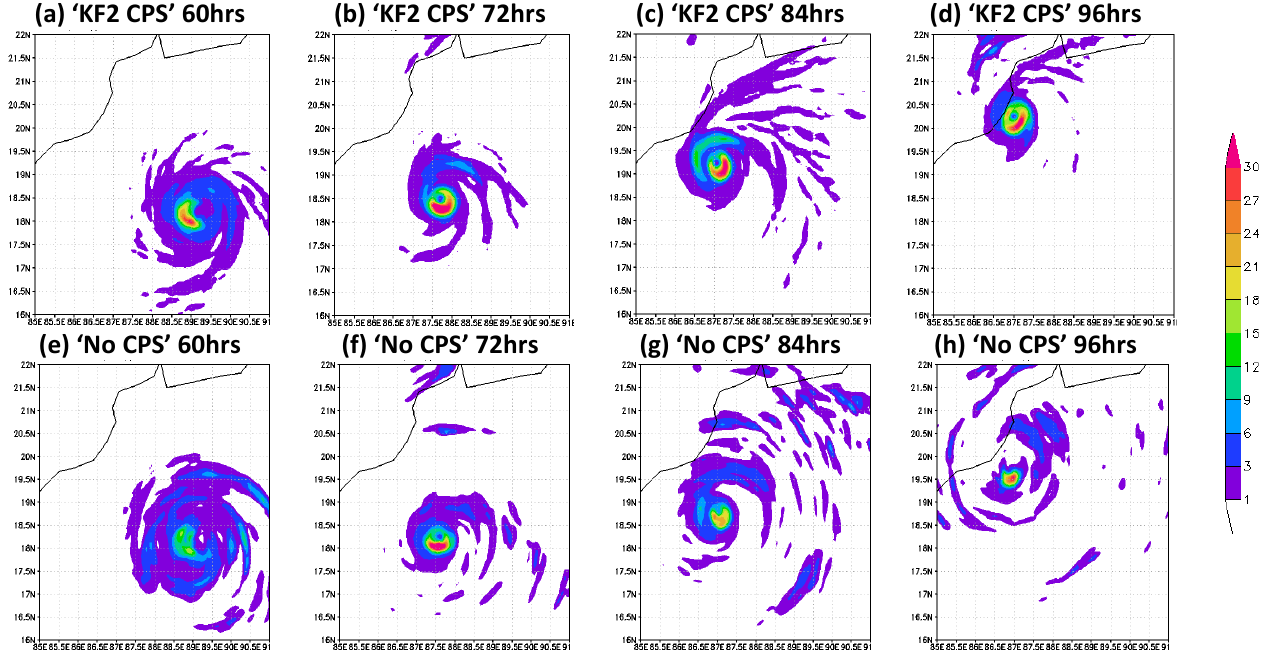
Fig. 7. Same as Fig. 5 but for the experiments of sensitivity to explicit modelling of convection: (a) – (d) with CPS of KF2 and (e) – (h) without any CPS in the D3 with three-domain configuration(45, 15, 5km